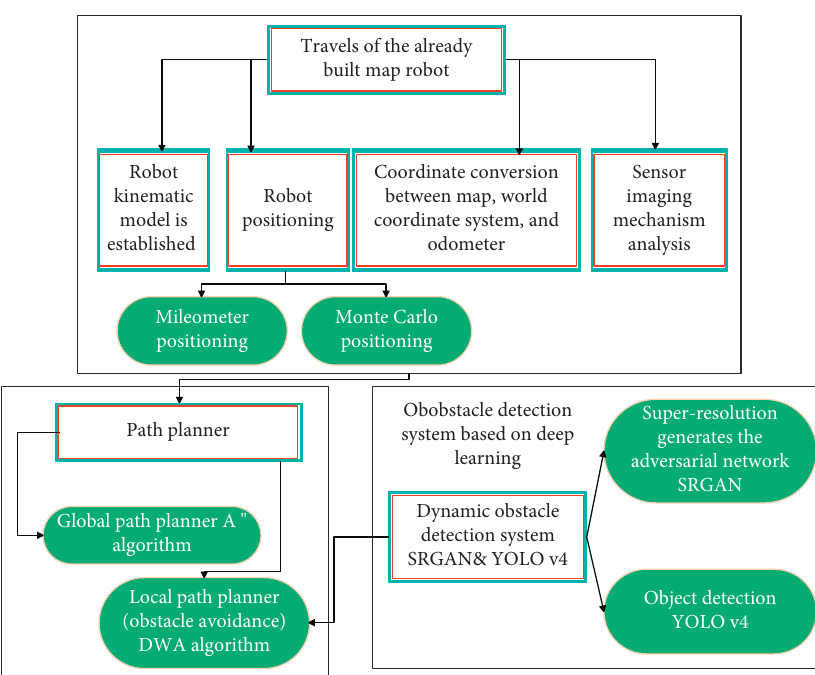
Figure 8: Overall architecture diagram of the robot route planning and obstacle avoidance system based on deep learning.